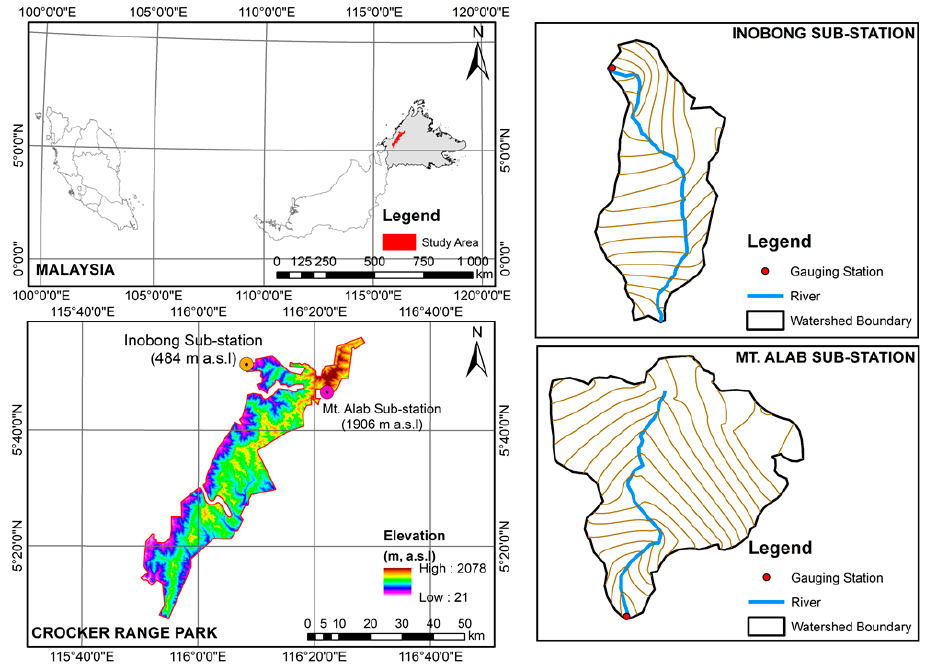
Figure 1. Study area.